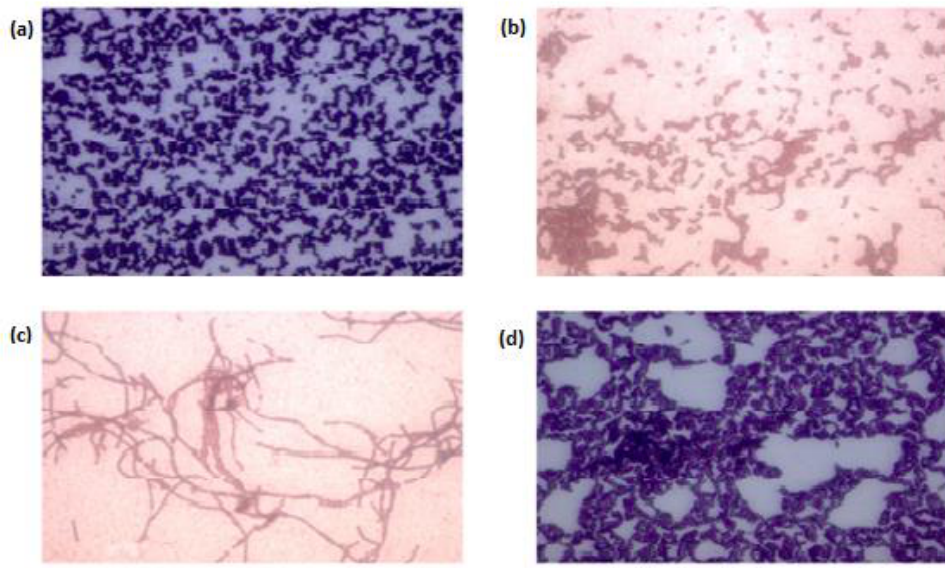
Figure 1. Gram staining of isolates for morphological identification. ( a , d ) Purple-colored Gram-positive bacterial isolates; ( b , c ) pink-colored Gram-negative bacterial isolates.